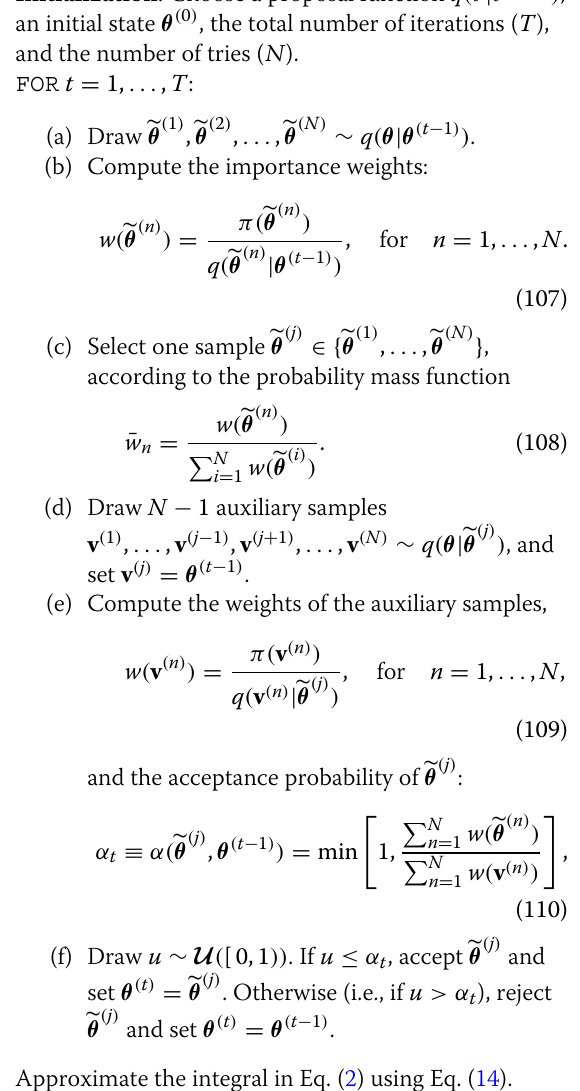
Algorithm 21 Multiple Try Metropolis (MTM)